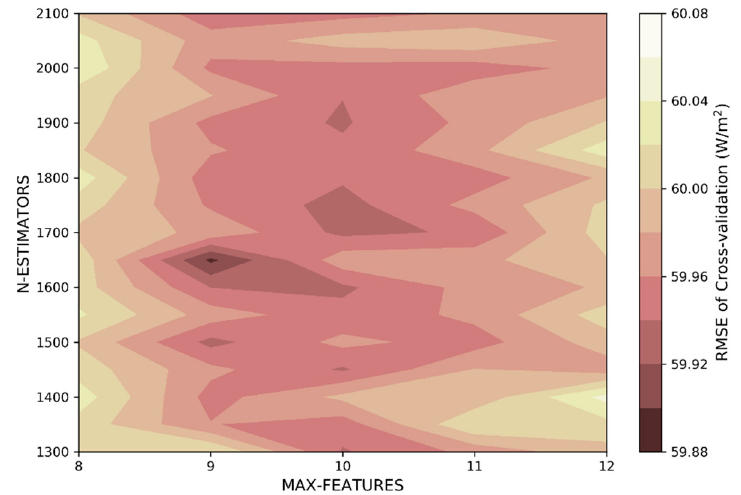
Figure 4. Cross-validation root mean square error (RMSE) of the Random Forest (RF) method with various hyperparameter